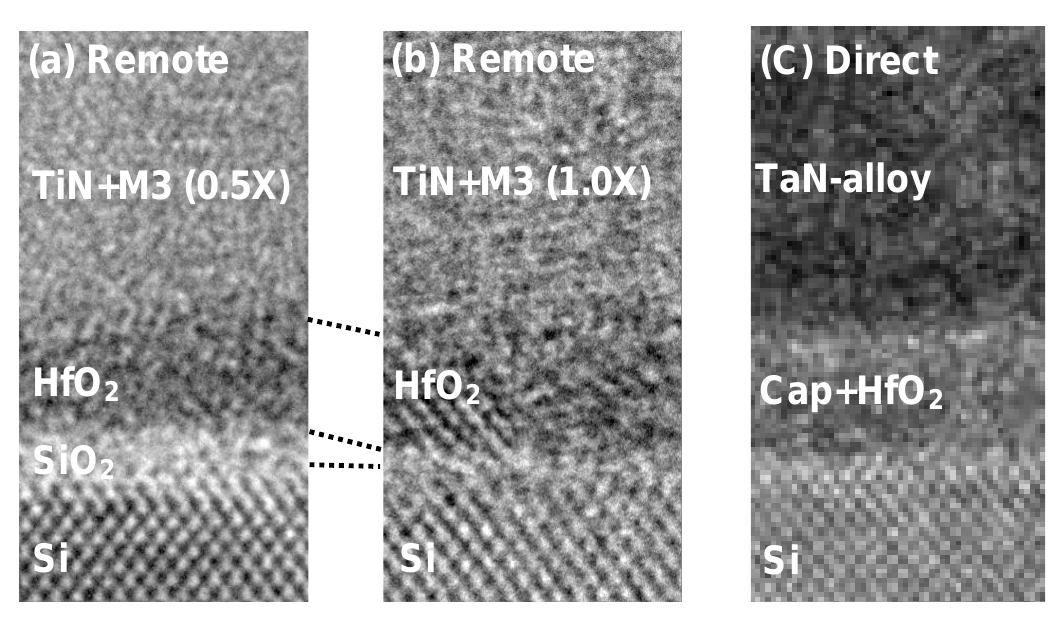
Figure 4. Cross-sectional transmission electron microscopy (TEM) images of the high- κ gate dielectrics and metal gate electrodes (HKMG) stacks for remote-scavenging with ( a ) medium scavenging metal dose; ( b ) high scavenging metal dose (after [19]); and ( c ) direct scavenging with TaN-alloy (after